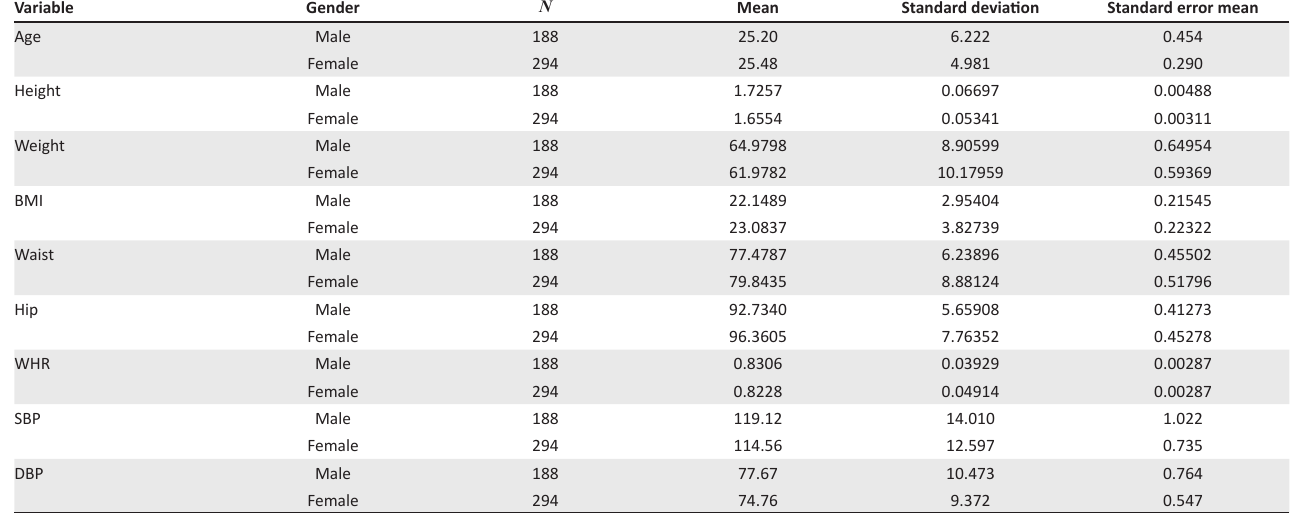
TABLE 2: Group statistics of the study population. Variable Gender